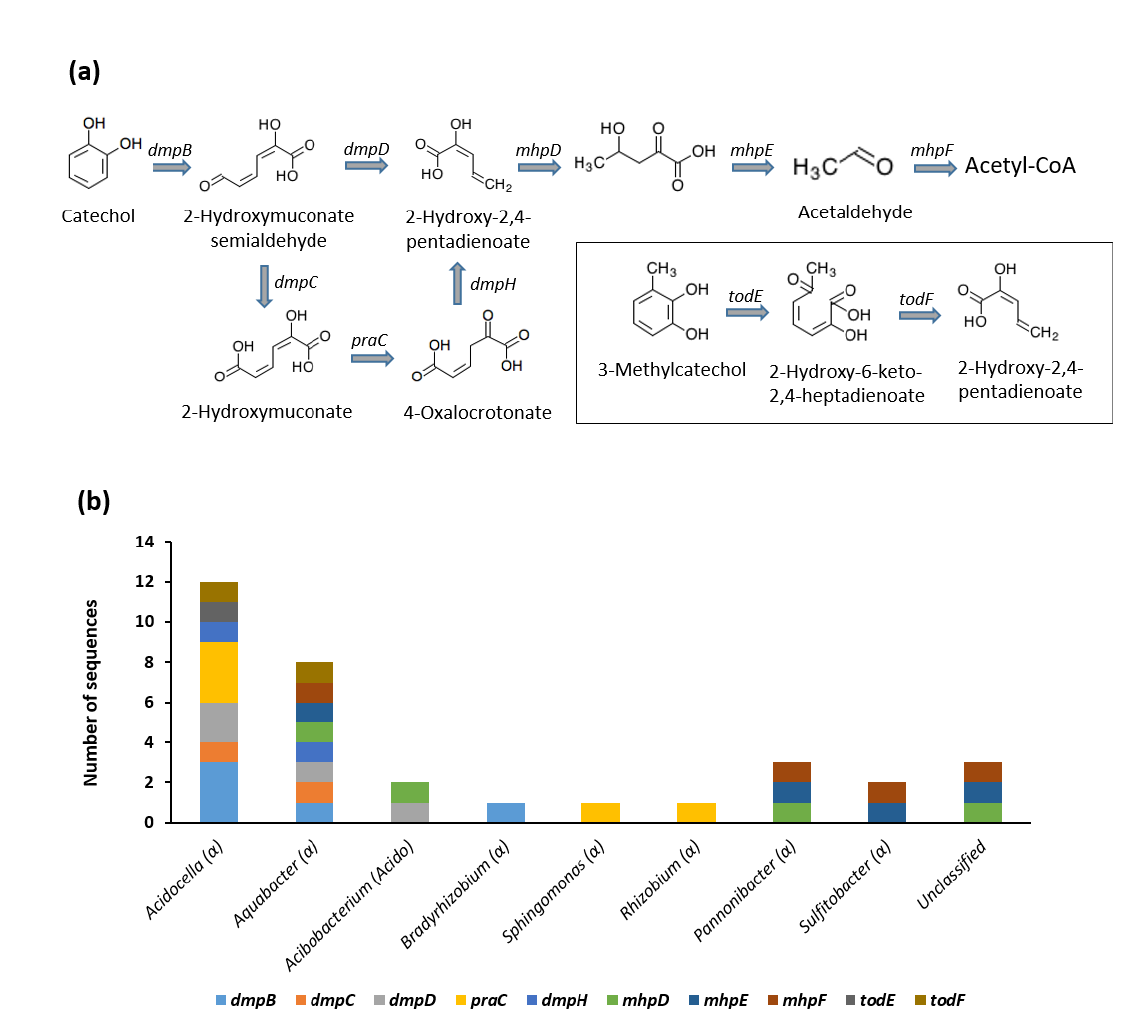
Figure 4. ( a ) Meta-cleavage of catechol and 3-methylcatechol. ( b ) Genus level assignment of the genes involved in meta-cleavage of catechol and 3-methylcatechol and their subsequent degradation reactions. Symbol (or letters) in parenthesis indicate the taxonomic class of each genus. dmpB : catechol 2,3-dioxygenase; dmpC : 2-hydroxymuconate-6-semialdehyde dehydrogenase; dmpD : 2-hydroxymuconate-semialdehyde hydrolase; praC : 4-oxalocrotonate tautomerase; dmpH : 2-oxo-3-hexenedioate decarboxylase; mhpD : 2-keto-4-pentenoate hydratase; mhpE : 4-hydroxy 2-oxovalerate aldolase; mhpF : acetaldehyde dehydrogenase; todE : 3- methylcatechol 2,3-dioxygenase; todF : 2-hydroxy-6-oxohepta-2,4-dienoate hydrolase.